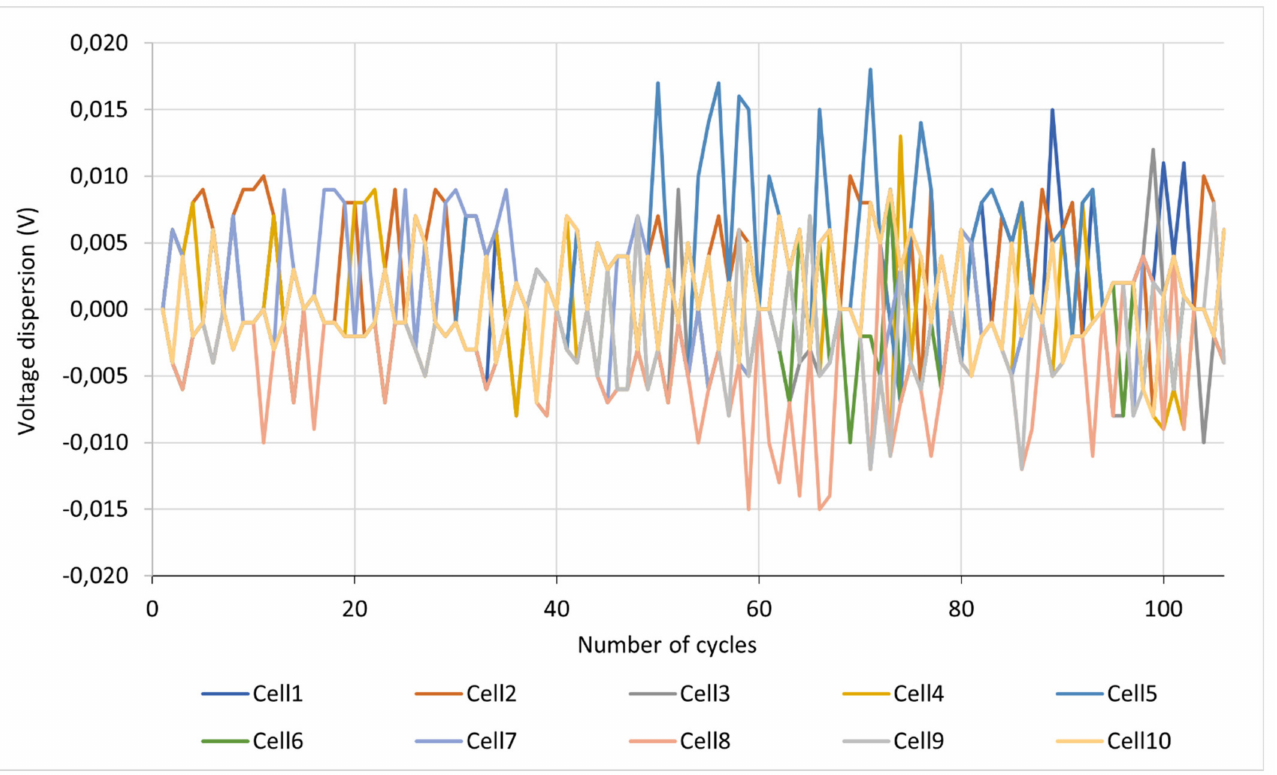
Figure 8. Voltage disperson per cell (battery 5).